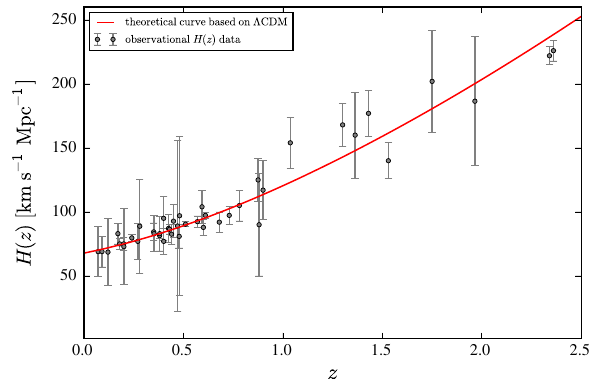
Fig. 1 The full OHD set and theoretical curve of standard flat Λ CDM model. The OHD are represented by gray points along with the uncer- tainties. The red curve shows theoretical H ( z ) evolution based upon the adopted Λ CDM model which is described in Sect.